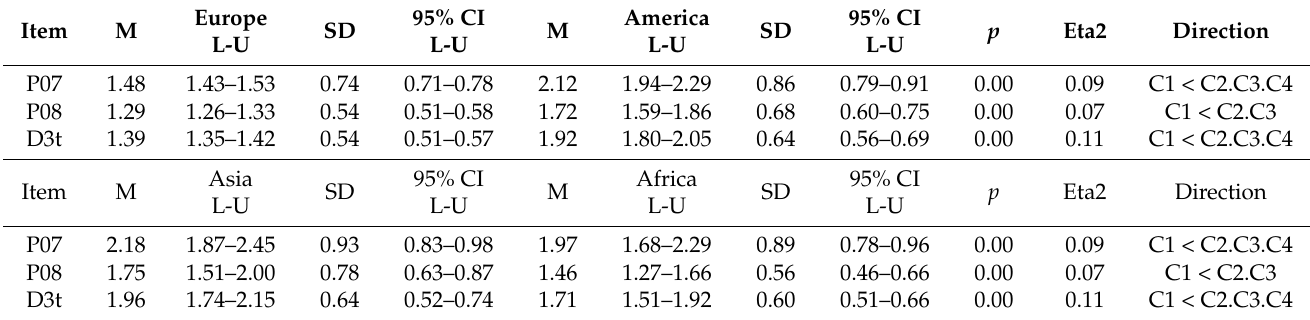
Table 12. ANOVA for independent samples by continent for dimension